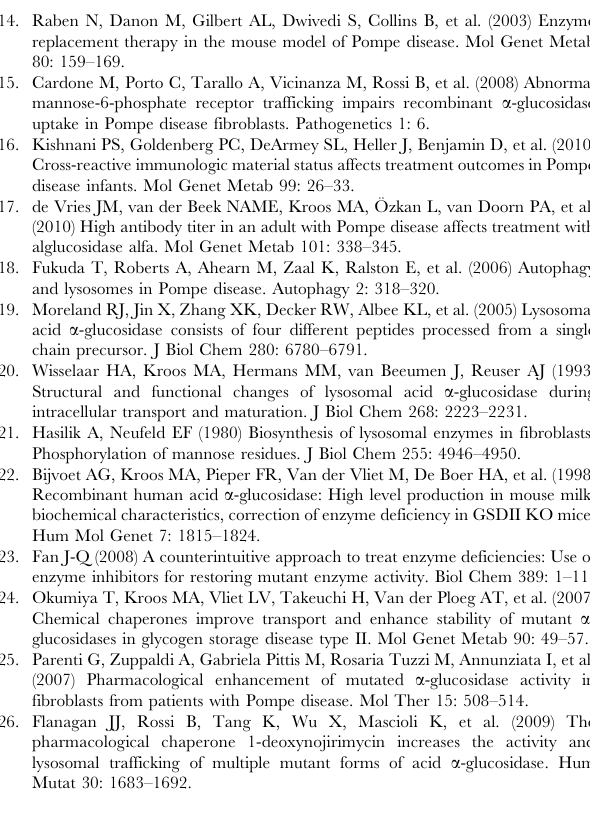
Figure S4 Repeat administration of rhGAA to hP545L GAA Tg/KO mice does not lead to high IgG